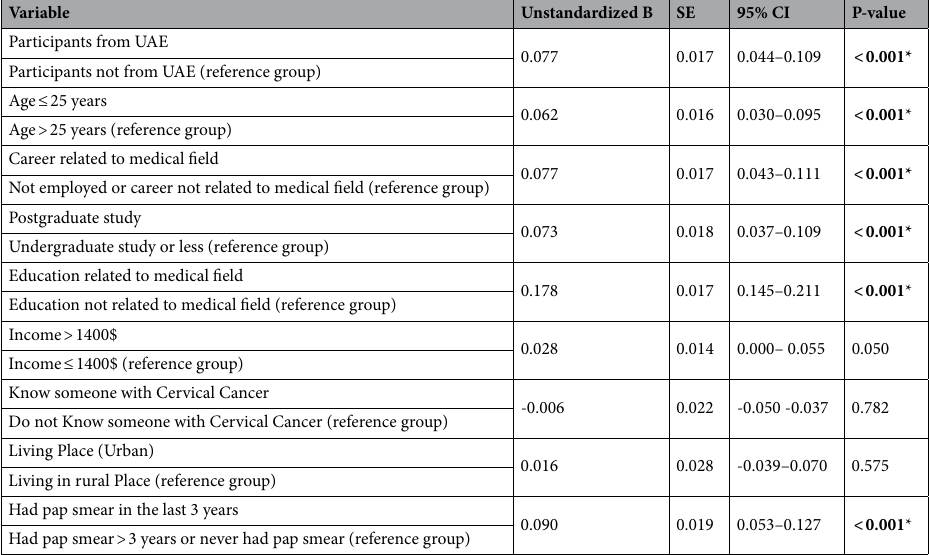
Table 3. Multiple linear regression analysis for variables associated with knowledge and awareness score about HPV and its vaccine (n = 2804). UAE: United Arab Emirates. *p-value <